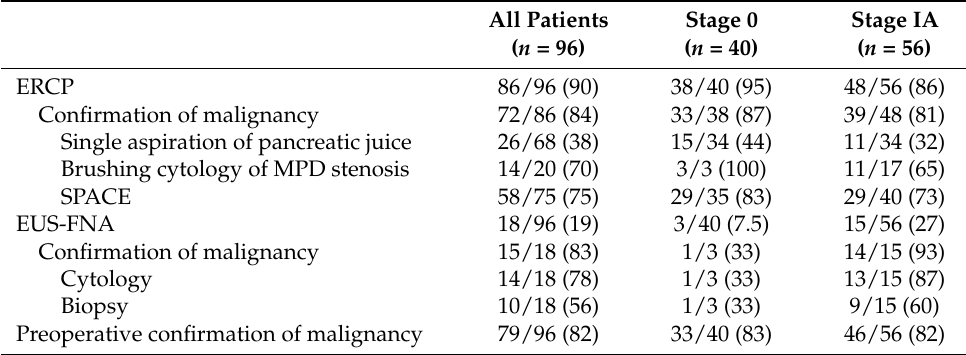
Table 5. Preoperative pathological diagnosis in patients with stage 0 and IA PDAC.